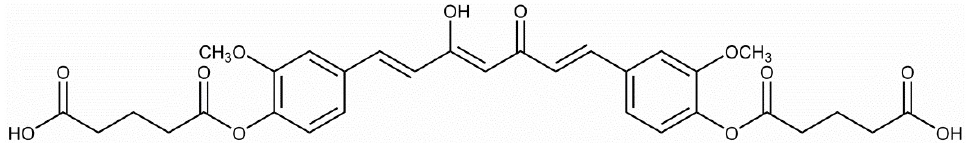
Figure 1. Chemical structure of curcumin diglutaric acid (CG).